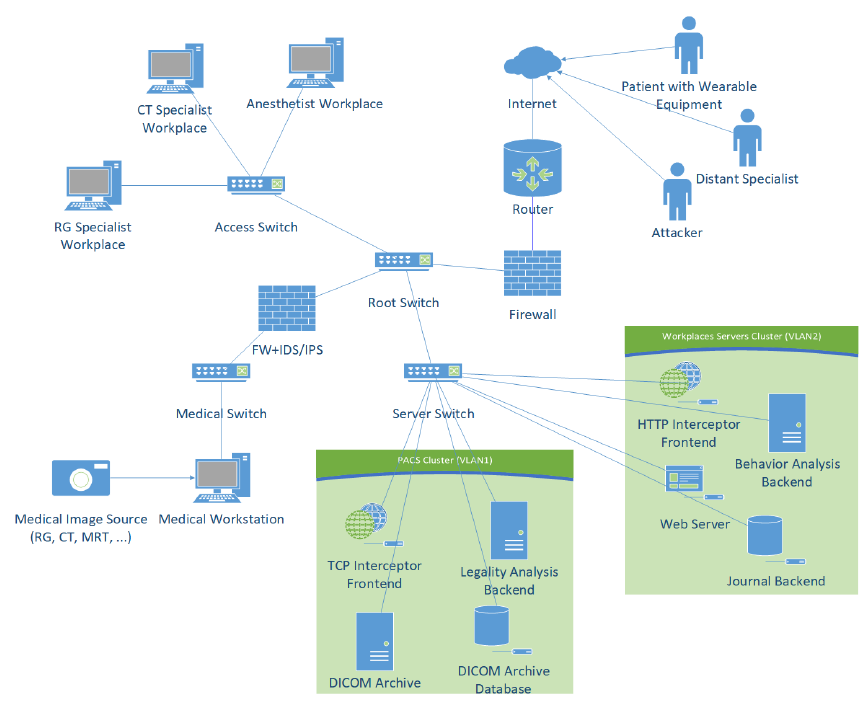
Figure 9. Network infrastructure with traffic